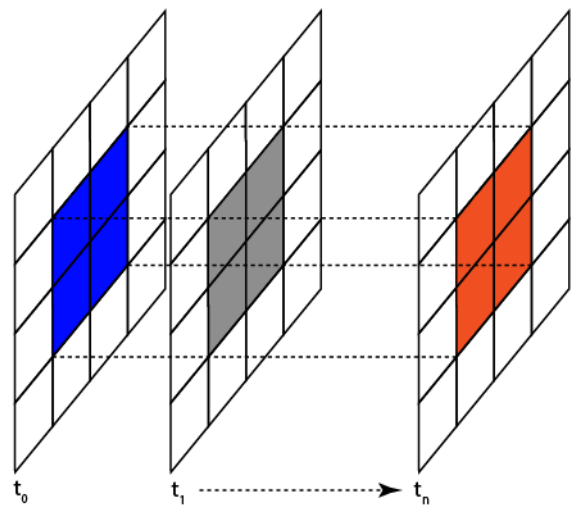
Figure 1. Subregion Discovery for t 0 ...t